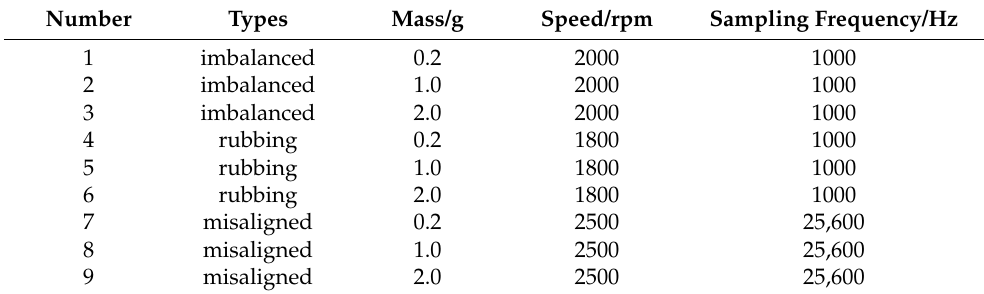
Table 3. Types of